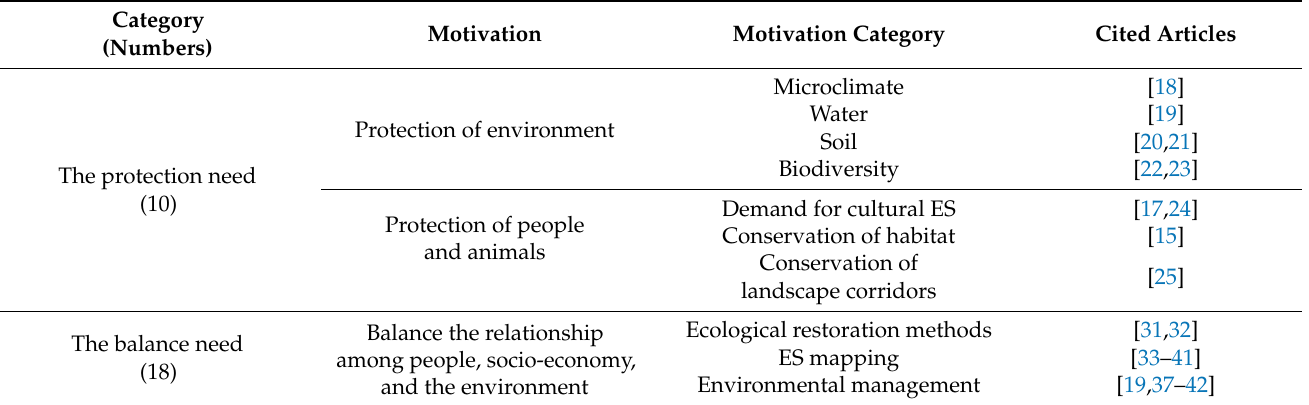
Table 1. Motivation for the research of sample